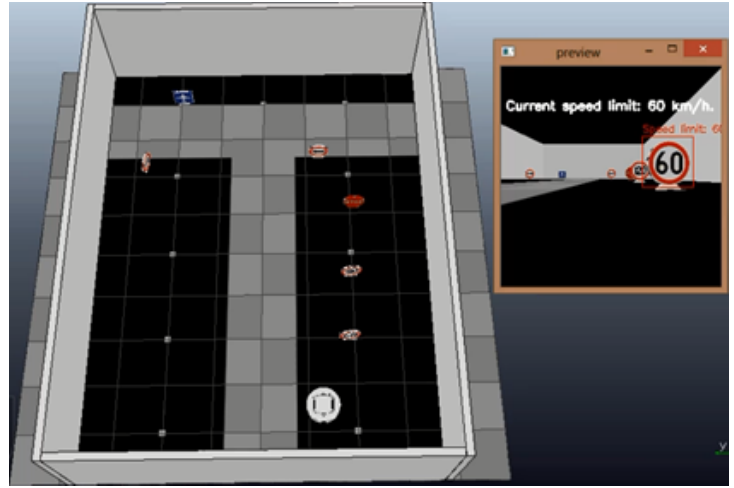
Figure 10. Experimentation detection of traffic signals in